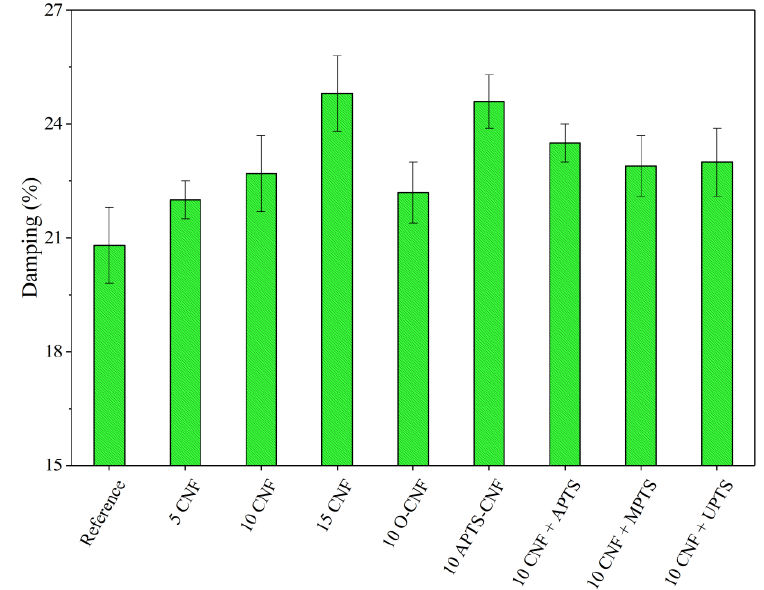
Figure 12. Relative damping parameters obtained for NBR composites with modified carbon nanofibers.